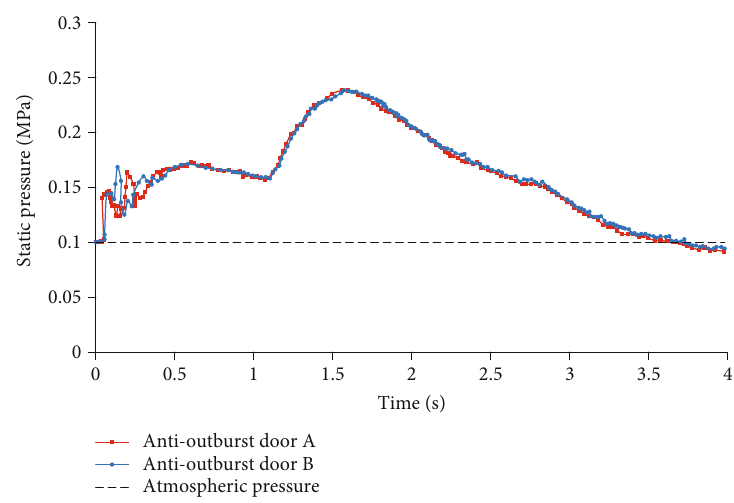
Figure 4: The static pressure change of antioutbursts door A and B in condition of exit C ( Θ = 0 : 2 ).